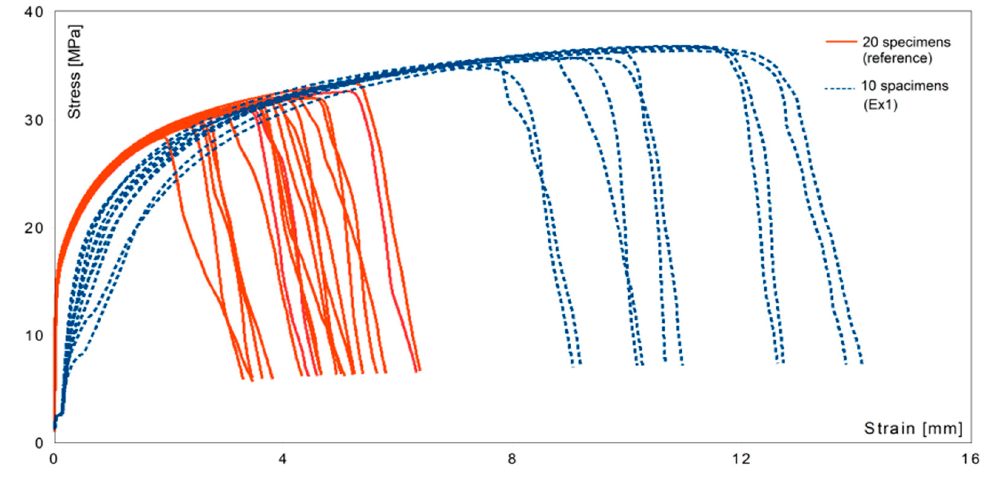
Figure 8. The stress versus the nominal strain curves for the specimens from the reference set and experimental (Ex1) set.